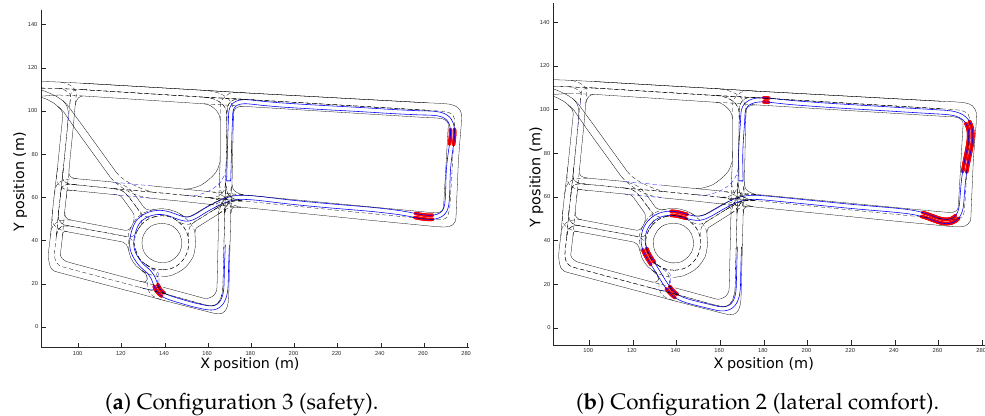
Figure 23. Lane invasion for the real